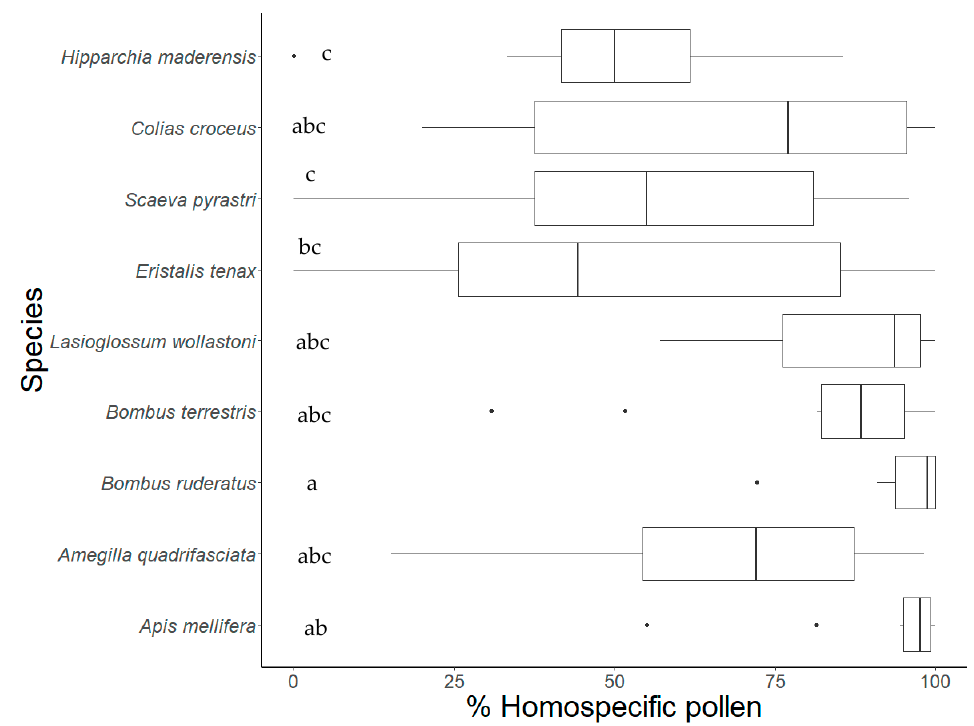
Figure 3. Percentage of homospecific pollen collected by the most common flower visitor species of E. candicans . Ten samples from 10 individuals/species. Data are presented as boxplots with descriptive values (minimum, first quartile, median, third quartile, maximum) and outliers. Letters designate groups of species that are statistically similar ( p < 0.05). Visitors belong to three animal groups: bees, hoverflies, and butterflies.